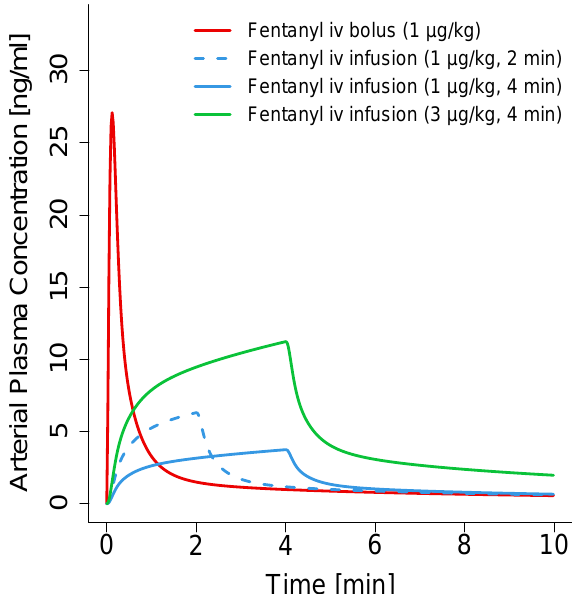
Figure 8. Simulations of arterial plasma concentration–time profiles after intravenous fentanyl bolus injection as well as 2- and 4-min infusions of di ff erent doses. Lines depict population geometric means ( n = 100). iv: